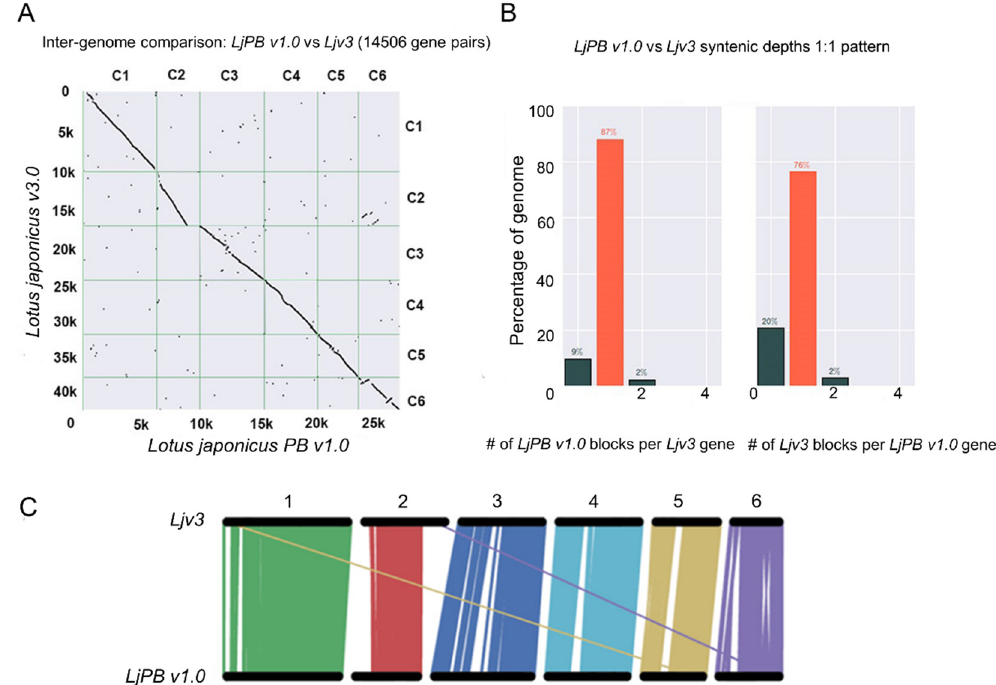
Figure 3. Inter-genome comparison. ( A ) Dotplot to visualize pairwise synteny. ( B ) Confirmation of the 1:1 synteny pattern. ( C ) Comparative physical mapping between LjPB_ver1.0 and Ljv3 shows similarity matching and mismatching of chromosome fragments.